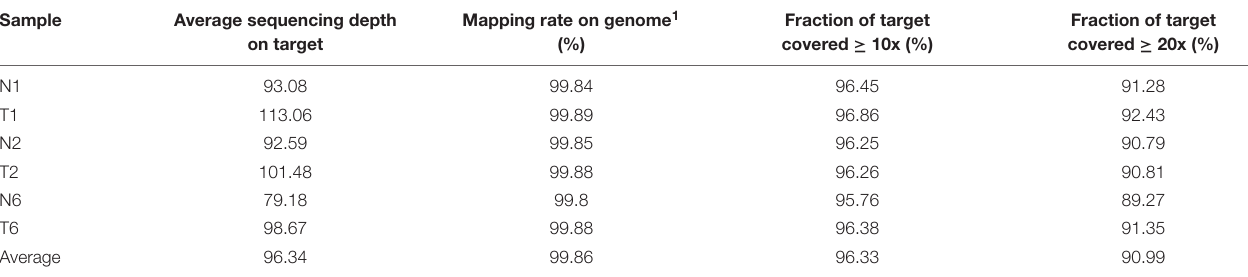
TABLE 4 | Summary of whole-exome sequencing data of six CR cell lines.